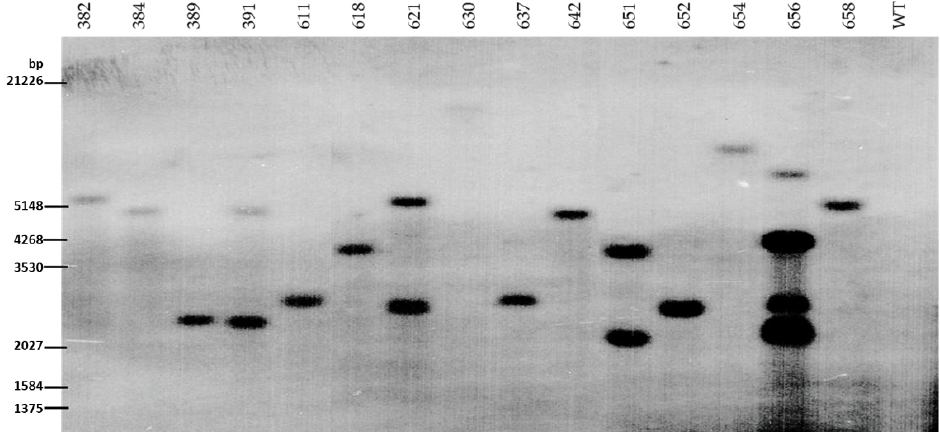
Figure 3. Southern blot analysis of mature Kuharske transgenic lines with EGFP probe. Lines 382, 384, 389, 391, 611 are AtPMI2 transgenics; lines 618, 621, 630, 637, 642 are CsPMI2 transgenics; lines 651, 652, 654, 656, 658 are CsPMI1 transgenics; WT = non-transgenic wildtype Kuharske. Plant genomic DNA was digested with Eco RV.